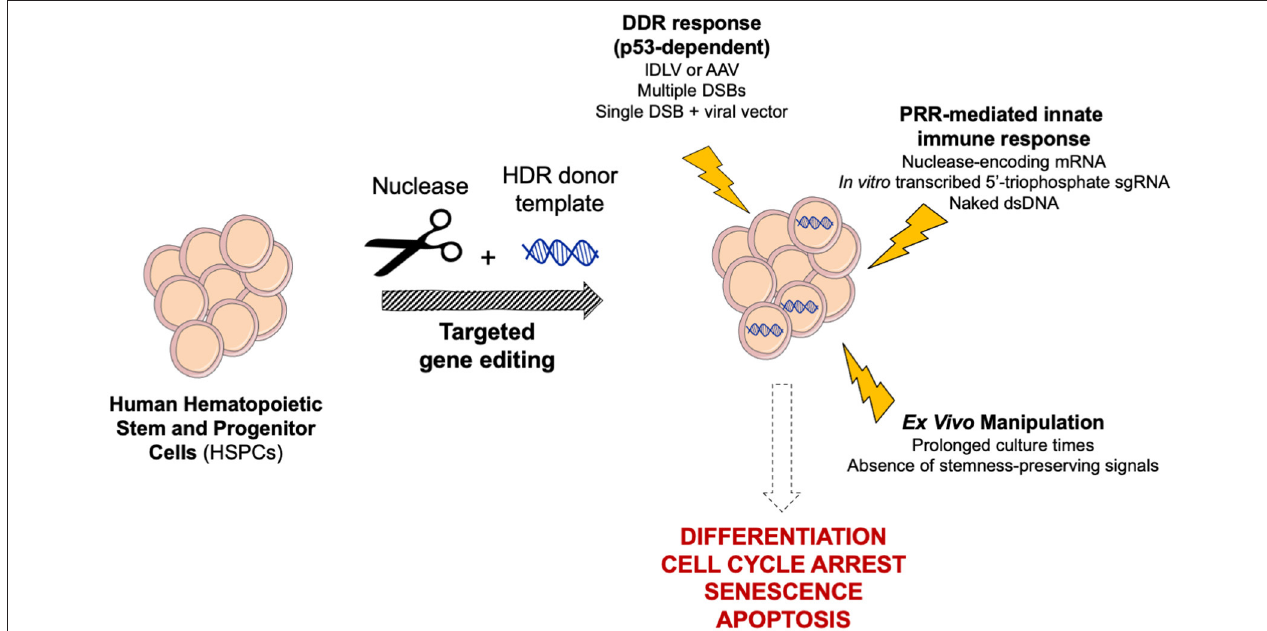
FIGURE 2 | Schematic of cellular responses triggered by targeted genome editing in human HSPCs. Gene editing reagents, procedure and ex vivo manipulation may trigger complex cellular responses in HSPCs, ultimately leading to differentiation, cell cycle arrest, senescence, and apoptosis. DDR, DNA Damage Response; PRR, Pattern Recognition